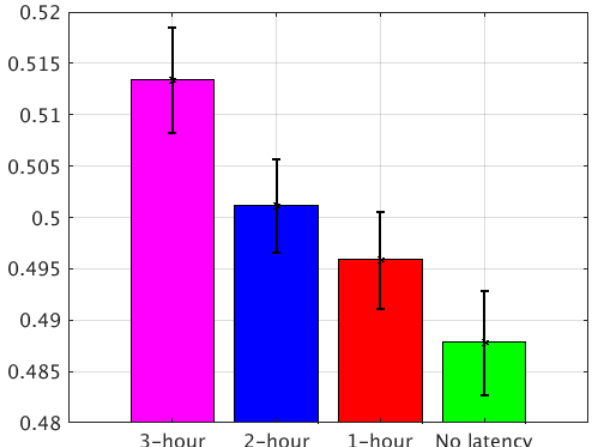
Figure 9. The final normalized RMSE of the four experiments with the 95% confidence intervals for Case II.